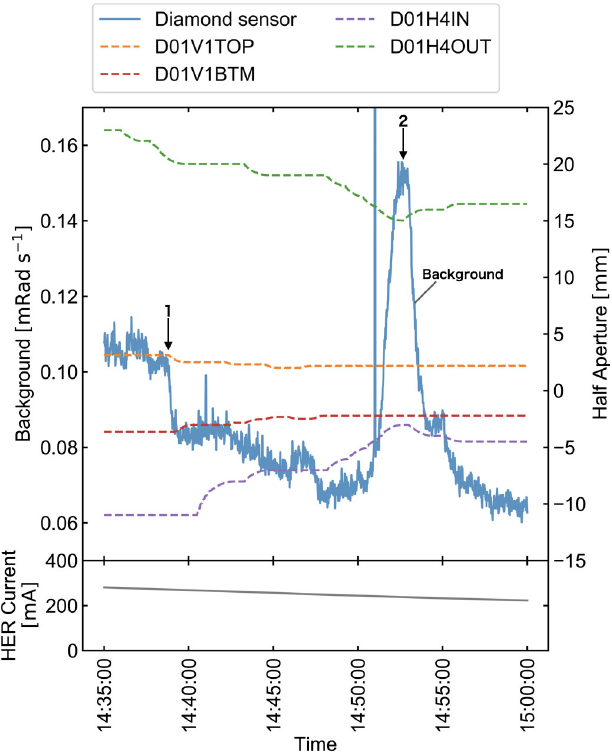
13. Example of effect of collimators on background in a diamond sensor of Belle II; half aperture of 0 mm refers to the center of the beam channel.